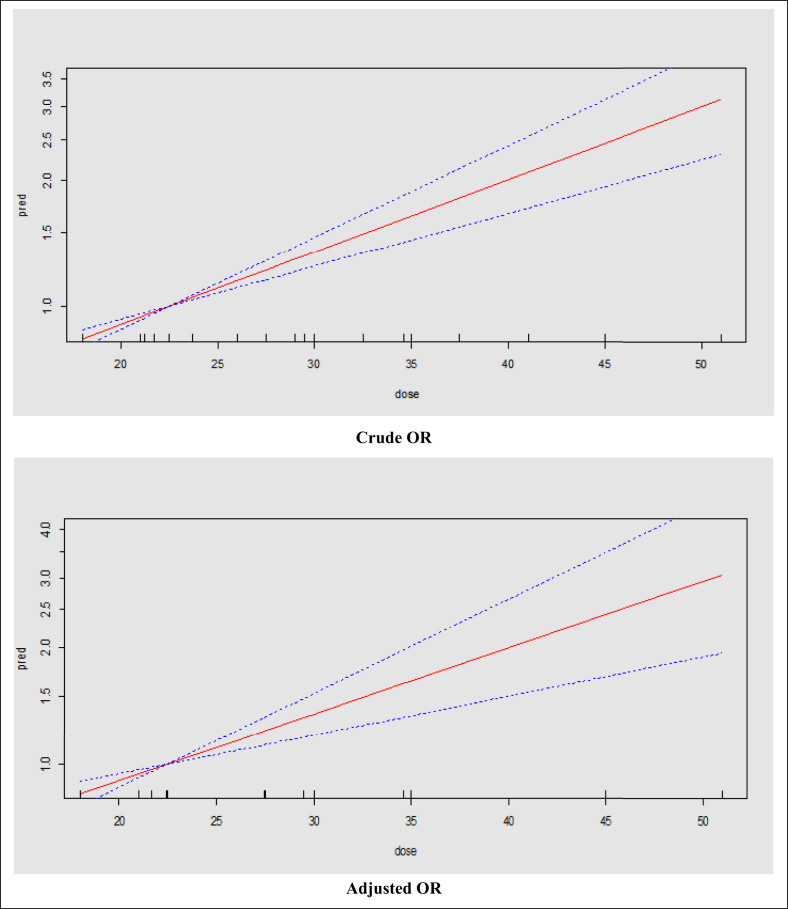
The dose-response relationship of BMI (kg/m2) and risk of BF cessation based on the linear model and crude and adjusted OR; the solid line represents the fitted linear trend and dash line represents the 95% confidence interval.